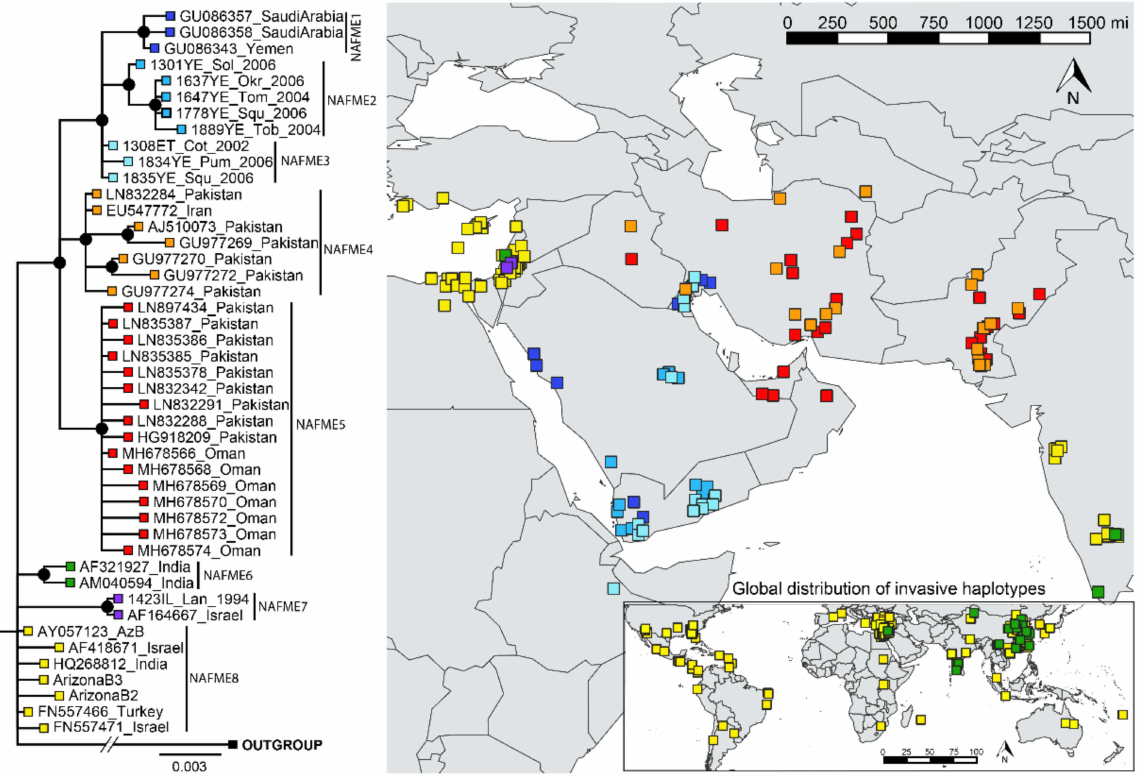
Figure 2. Phylogeography of all known B mitotype haplotypes of Bemisia tabaci . The phylogenetic breaks coincide with the SNPs classification of haplotypes given in Table